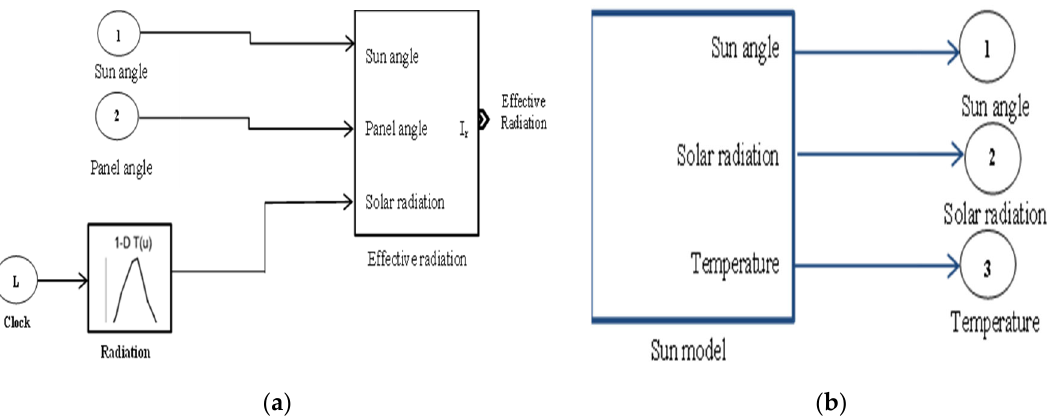
Figure 2. Block diagram of ( a ) effective radiation quantity; ( b ) modeling of the sun.